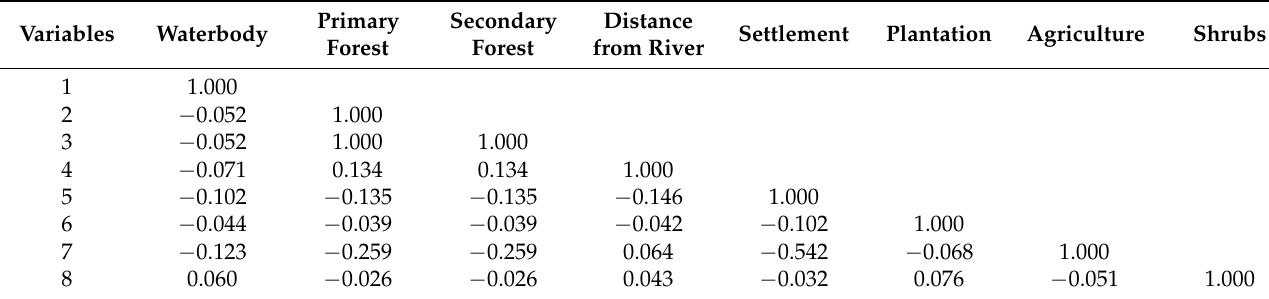
Table 4. Results of multicollinearity analysis in